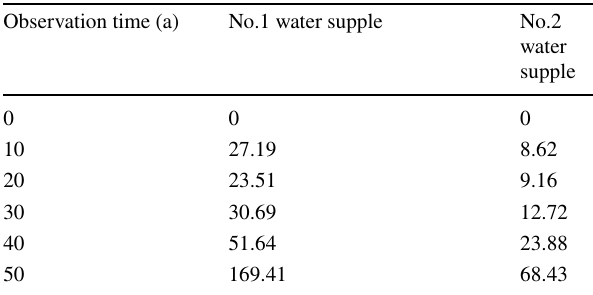
Table 4 Simulation results of each period for the optimal solution